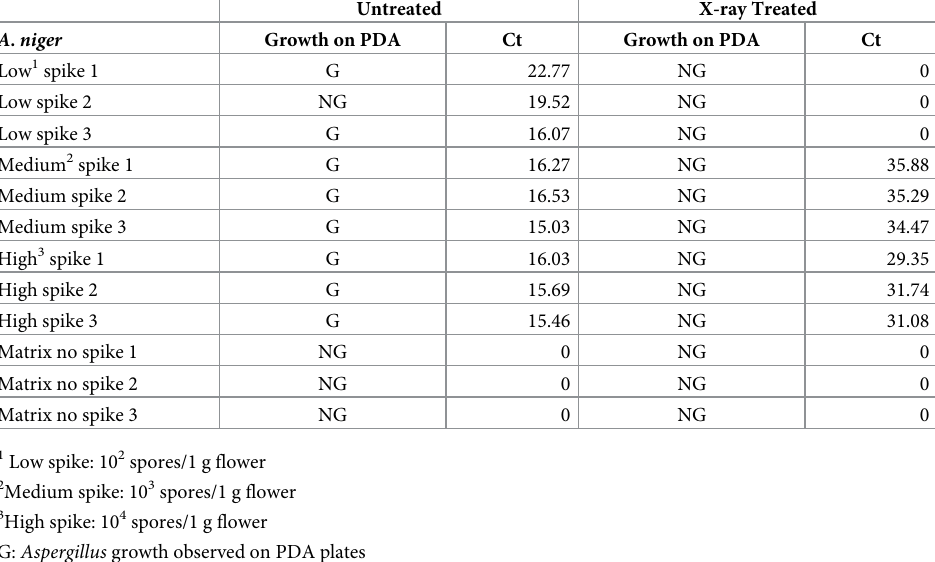
were detectable by PCR, even after X-ray exposure. In samples without X-ray exposure irradia- tion, respective Aspergillus spp . were detected by PCR regardless of spike level, see Tables 3–6. Irradiated medium and high spike samples resulted in detectable Ct values although with later